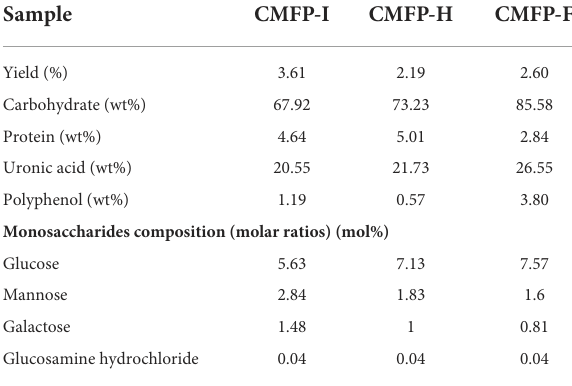
TABLE 1 Extraction yields, chemical properties, and constituent monosaccharides of the polysaccharides from fruiting bodies of Cordyceps militaris under different drying